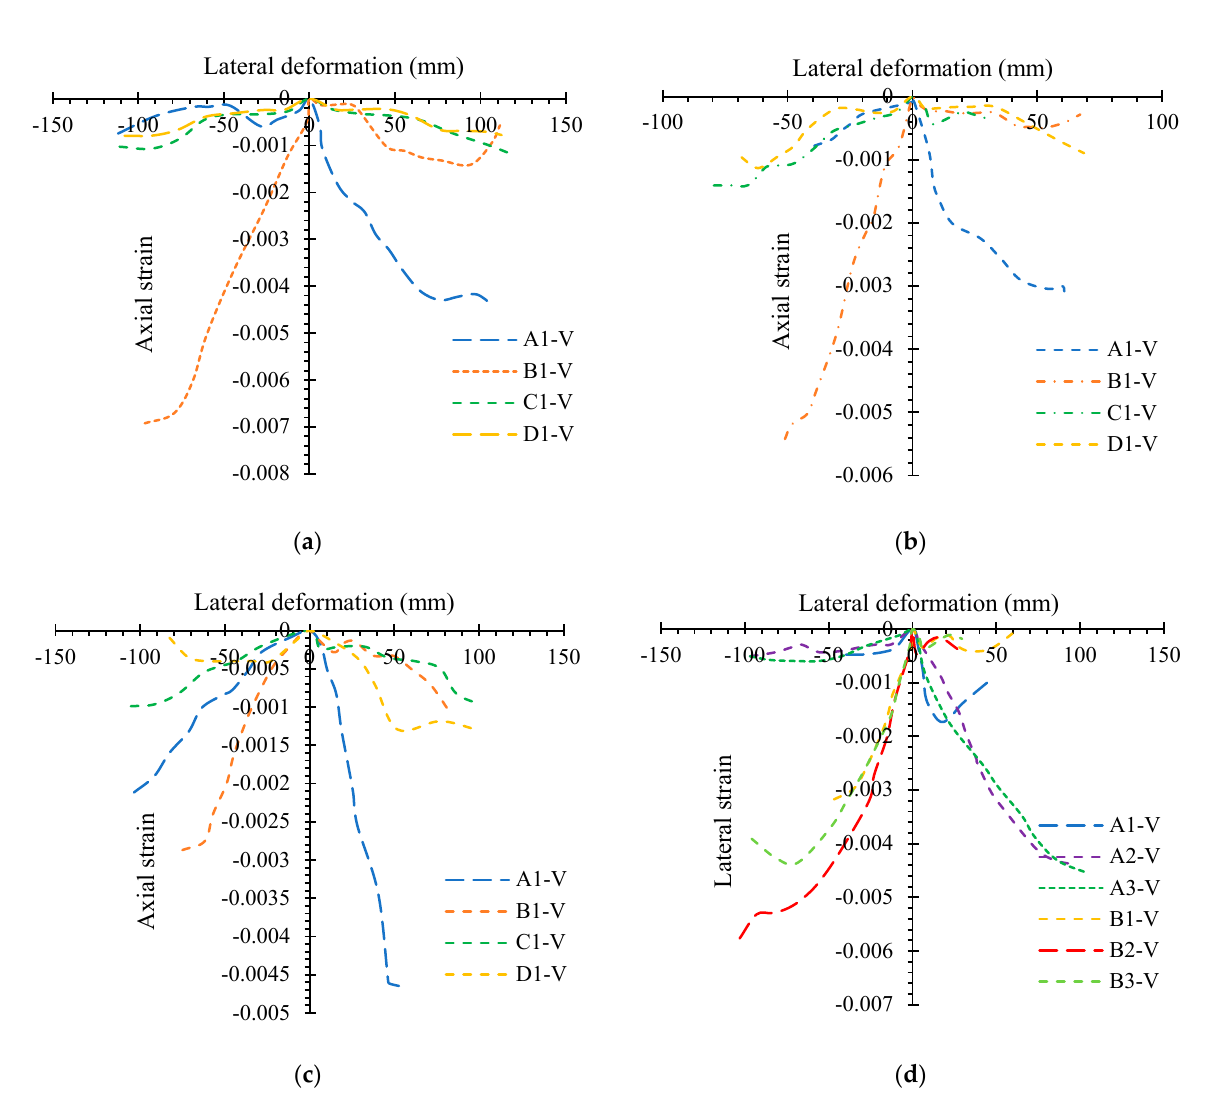
Figure 10. Axial strains of GLT: ( a ) RAGC50-0.4-STT8 for the same elevation; ( b ) RAGC0-0.2-STT8 for the same elevation; ( c ) RAGC100-0.2-STT8 for diverse elevations; ( d ) RAGC50-0.2-STT10 for the same elevation. Table 5. Measurement of rotations and